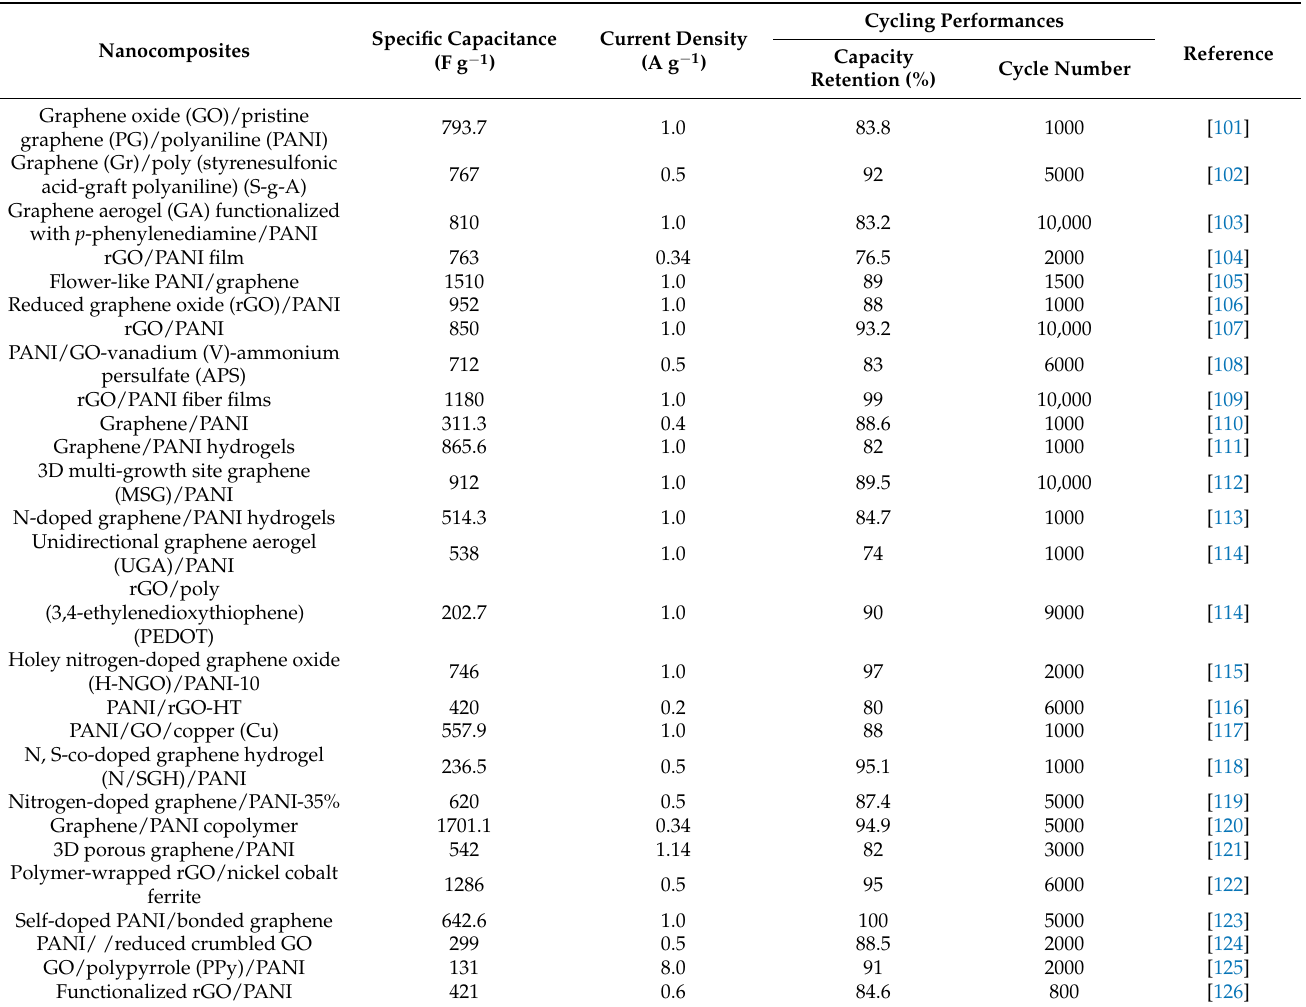
Table 2. Supercapacitor milestones of graphene polymer